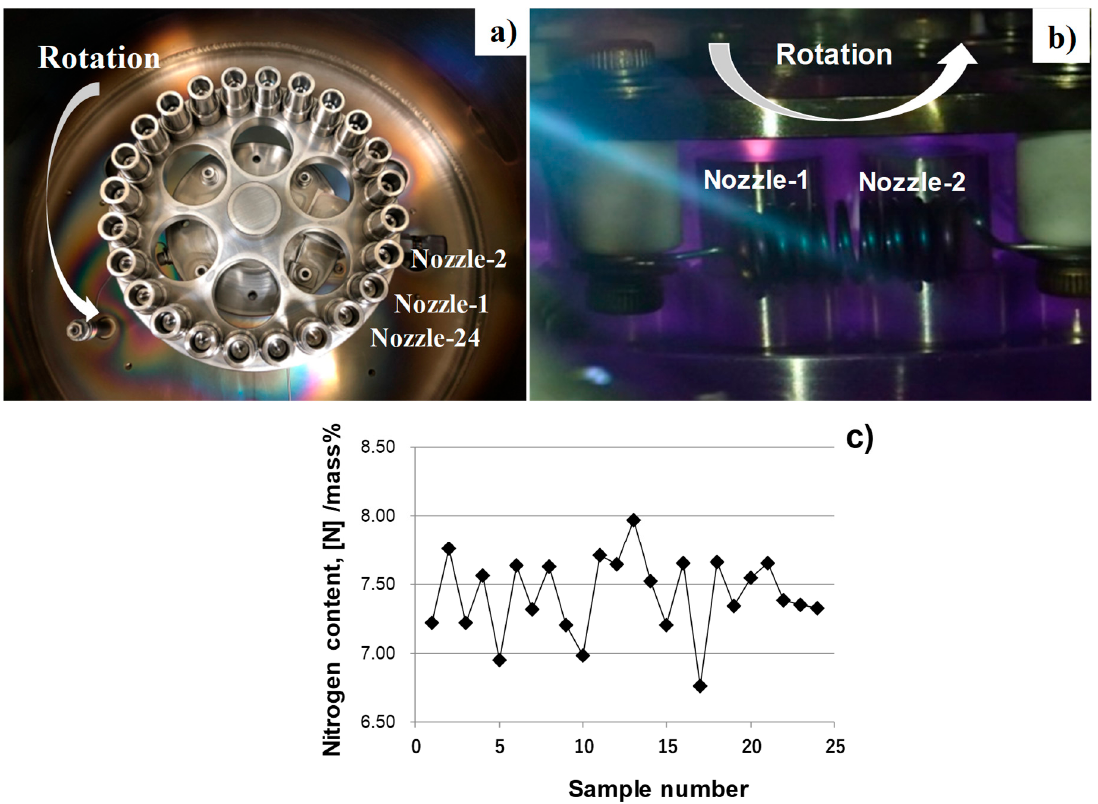
Figure 7. Simultaneous nitriding behaver of 24 micro-nozzles. ( a ) Experimental setup of 24 micro-nozzles into the DC-biased plate with heaters, ( b ) An experimental set-up for simultaneous plasma-nitriding of 24 micro-nozzles, and, ( c ) Statistical distribution of the surface nitrogen content among 24 nitrided micro-nozzles at 673 K for 7.2 ks.